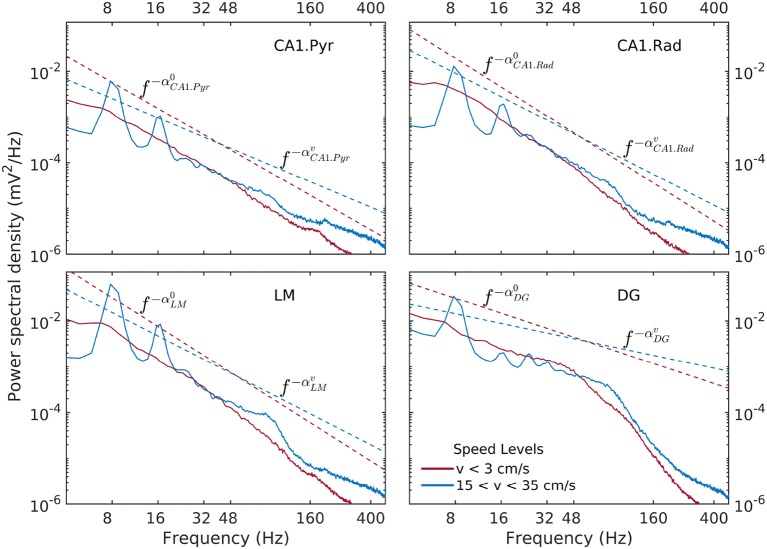
Power spectral density as a function of rat and hippocampal layer for low (red) and high rat speed (blue). The logarithmic representation used in this figure is useful for detecting frequency intervals where the spectrum follows a power law of the form S(f)=S(f0)(ff0)-α, because in this representation of the the relation S(f) becomes linear, e.g., log10S=log10S0-αlog10(ff0). The absolute value α of the exponent is loosely referred to as “spectral slope.” Dashed lines (offset for better visibility) represent power laws shapes f−α that approximately match the observed spectra for 6Hz < f < 50Hz. Low-speed spectral slopes are αCA1.Pyr0≈1.9, αCA1.Rad0≈2.1, αLM0≈2.1, and αDG0≈1.1. High-speed spectral slopes are αCA1.Pyrv≈1.4, αCA1.Rad0≈1.7, αLM0≈1.7, and αDG0≈0.7. Data was produced from rat r539♂-maurer.